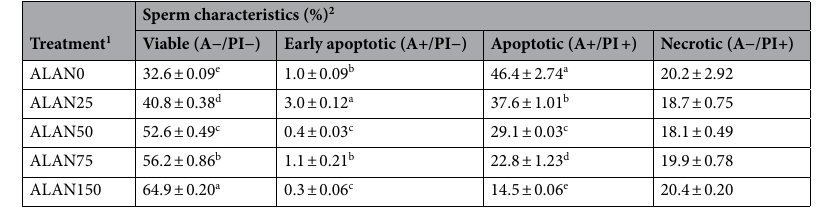
Table 6. Effect of supplementing Tris-extender with alpha-lipoic acid loaded liposomes (ALAN) on apoptosis- like changes of post-thawed buffalo bull sperm (Annexin V/PI assay). 1 Tris extender supplemented with different levels of alpha-lipoic acid loaded liposomes (ALAN) containing 0 (ALAN0), 25 (ALAN25), 50 (ALAN50), 75 ALAN75 and 150 ALAN150 (0, 25, 50, 75 and 150 µg/mL), respectively. 2 a–e means denoted within the same column with different superscripts are significantly different at P <